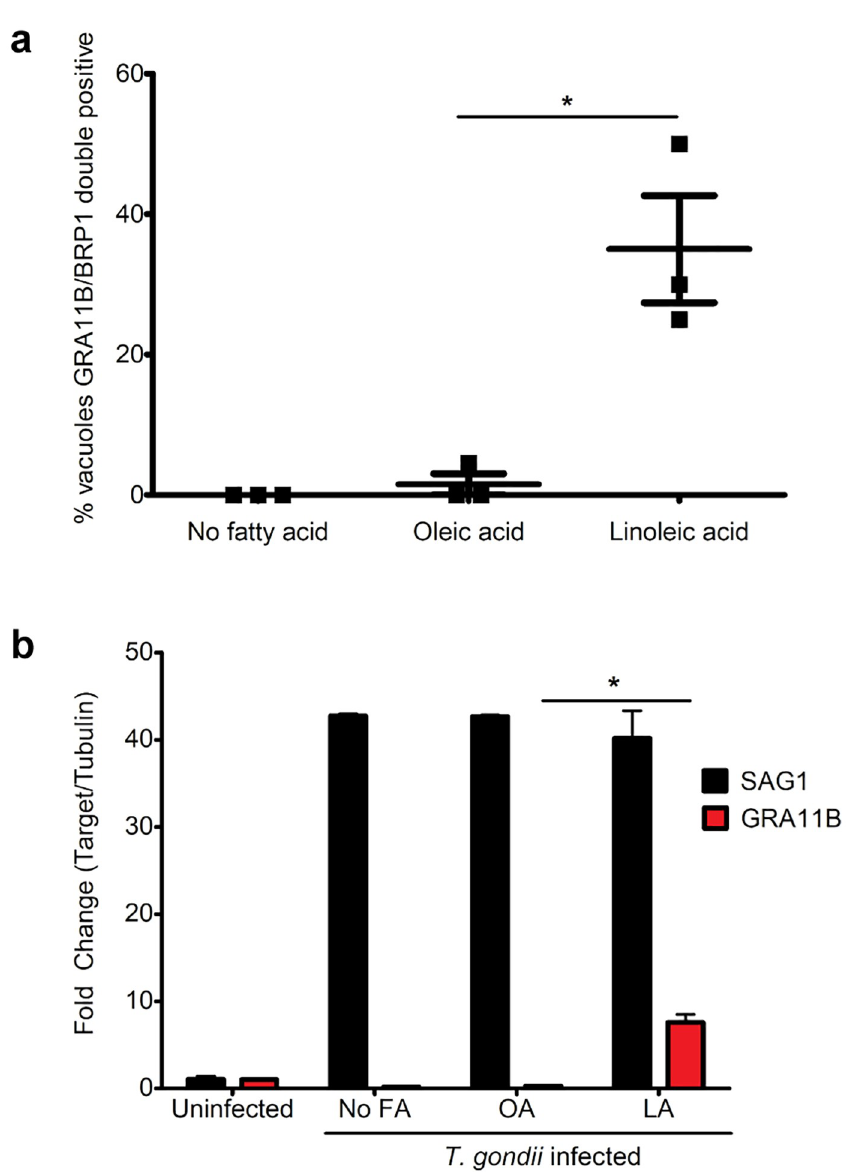
Fig 2. Quantification of merozoites in cat tissue culture. (a) Cat intestinal organoids were disassociated by trypsin and then grown as monolayers on glass slides. Slides were divided into three different groups: not supplemented with FA, supplemented with 200 μ M OA, or supplemented with 200 μ M LA. Monolayers were infected with T . gondii ME49 bradyzoites purified from brains of chronic infected mice at a 1:10 MOI. Five days after infection, staining for GRA11B and BRP1 along with DAPI allowed the percentage of vacuoles positive for GRA11B and BRP1 out of the total vacuoles to be determined. Total number of parasitophorous vacuoles were counted by positive DAPI staining and confirmed by morphology with DIC. Three biological replicates were counted, and on average, 35% of the total vacuoles were positive for both GRA11B and BRP1 in the LA-supplemented monolayers. � p -value = 0.0126 with N = 3 by two-tailed unpaired t test. Straining for both BRP1 and GRA11B was used to ensure that merozoite stages were counted. RNAseq and immunofluorescent imaging of the cat intestinal epithelium show that GRA11B is exclusively expressed in merozoites [6]. BRP1 is a rhoptry protein that was initially found in bradyzoites; however, it is also expressed in merozoites [7]. (b) Cat intestinal monolayers were grown as described in (a), except monolayers were quenched by TRIzol 5 days post infection, RNA was extracted, and cDNA was synthesized using an oligo (dT) primer to amplify mRNA. Expression of SAG1 and GRA11B were quantified by qPCR and the fold change calculated in comparison with uninfected cells. TUB1A was used to normalize gene expression across samples. GRA11B expression was significantly more abundant in the LA-supplemented monolayers with two biological replicates. � p -value = 0.0155 with N = 2 by two-tailed unpaired t test. BRP1, bradyzoite rhoptry protein-1; DIC, differential interference contrast; FA, fatty